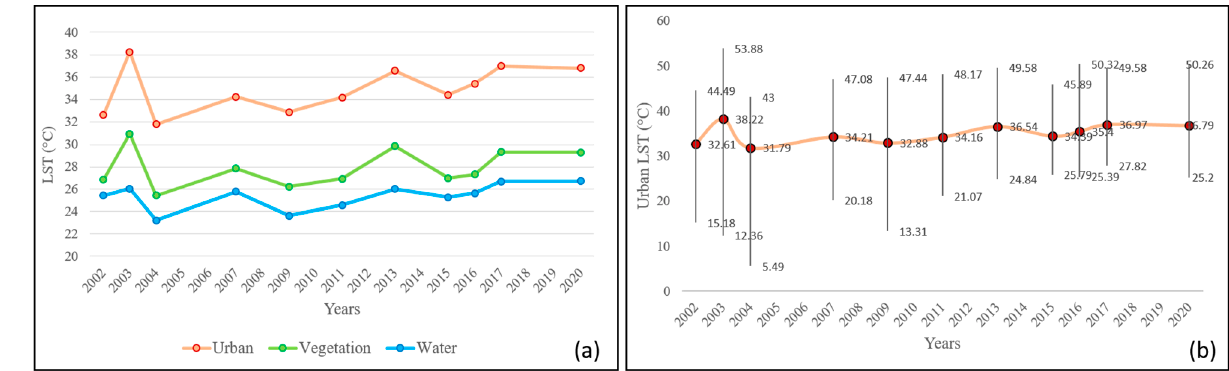
Figure 6. The mean LST values of urban, vegetation and water land cover areas ( a ), and minimum, maximum and mean LST values of urban areas ( b ).